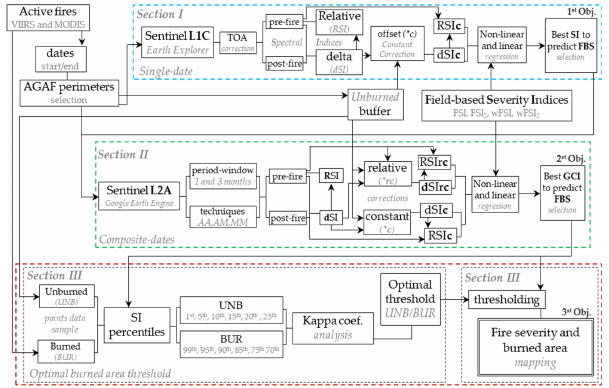
Figure 2. Summary of the study methodology for analyzing Sentinel-2 imagery performance for: (i) evaluating spectral indices from paired dates to predict field-observed fire severity ( Section I ); (ii) comparing image composites of varying length (1 or 3 months), composite technique (average or minimum), and phenological correction ( c or rc ) for predicting field fire severity ( Section II ) and for (iii) mapping burned area perimeter ( Section III ). Where: AGAF: aggregated active fire perimeters (2.3.1), TOA : top-of-atmosphere, dSI : differenced spectral index (Equation (29)), RSI : relative spectral index (Equation (31)), c: constant phenological correction (Equation (30)), SI : spectral index, FBSs : field-based fire severity indices, FSI: field severity index (Equation (1)), FSI 2 : field severity index 2 (Equation (2) ) , wFSI : weighted field severity index (Equation (3)), wFSI 2 : weighted field severity in- dex 2 (Equation (4)), AA , AM , MM : compositing technique (Table 4), rc: relative phenological cor- rection (Equation (32)), and GCI: Google Earth Engine composite index.